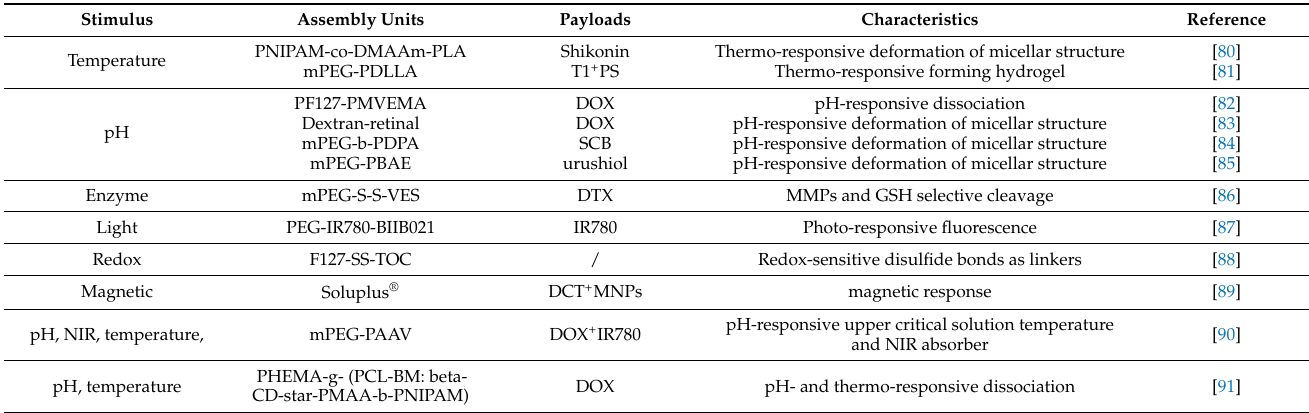
Table 2. Examples of stimuli-responsive polymeric micelles in breast cancer